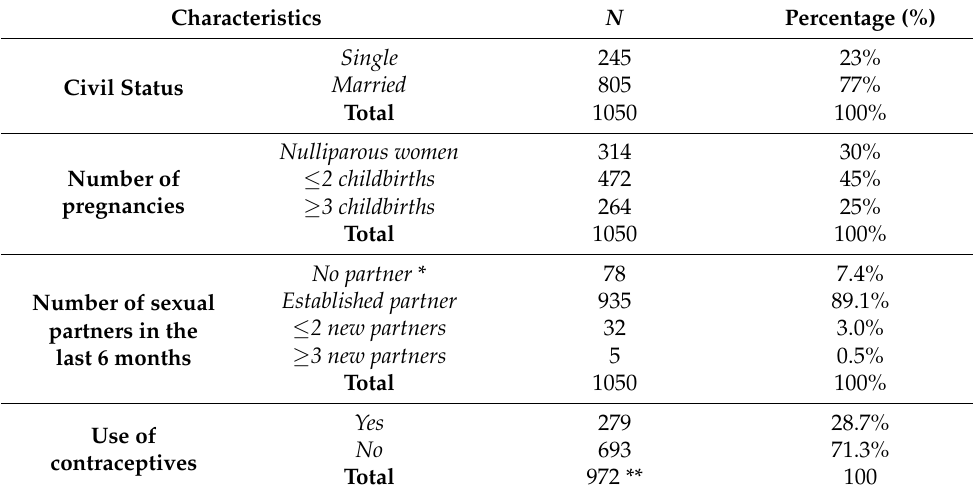
Table 1. Demographic information of the study population ( N =